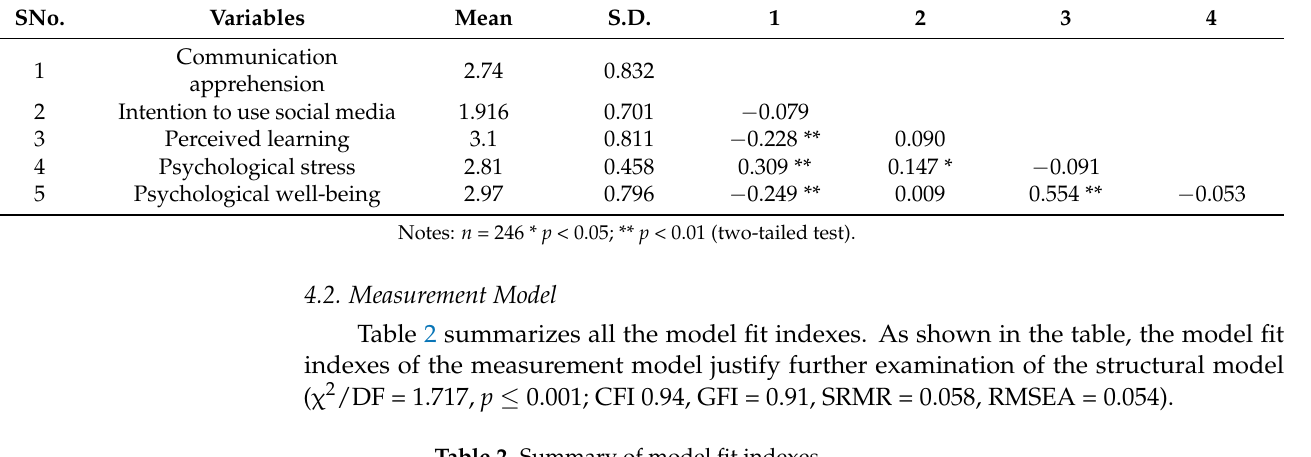
Table 2. Summary of model fit